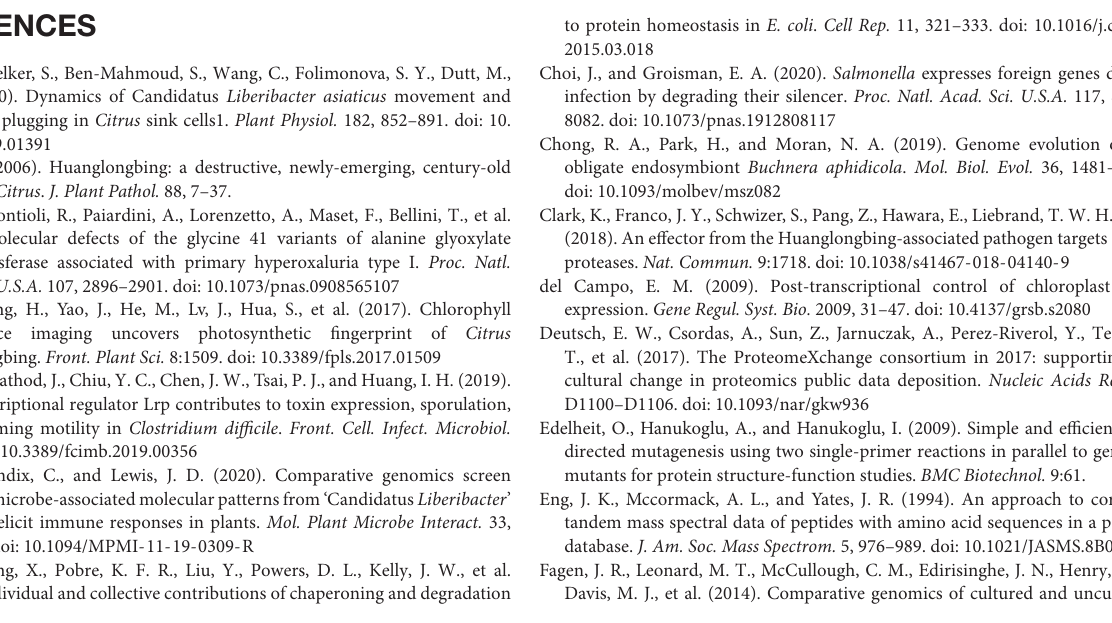
Supplementary Figure 1 | Conserved amino acids across LotP domains. Alignment of ‘ Ca . L. asiaticus’ LotP sequence (#1) with homologs encoded in phylogenetically close organisms (#2–10) and phylogenetically distant organisms (#11–14). Alignment with homologs encoded in the order Rhizobiales – (#2–10)